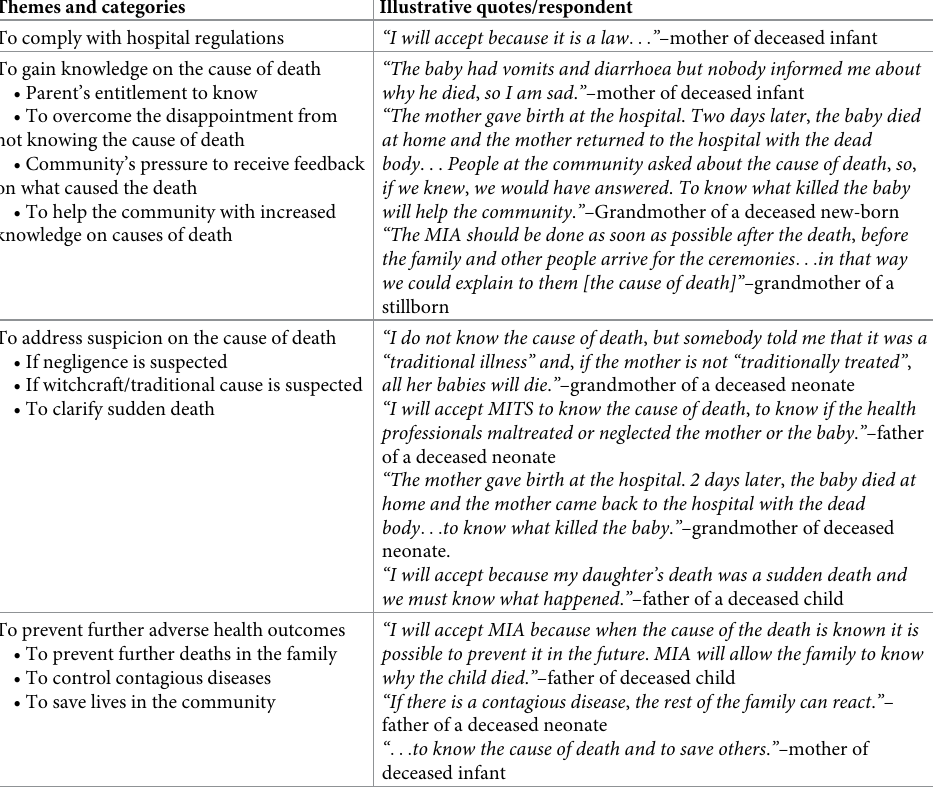
Table 2. Parents and guardians accounts of anticipated drivers to accept the performance of MITS on their deceased